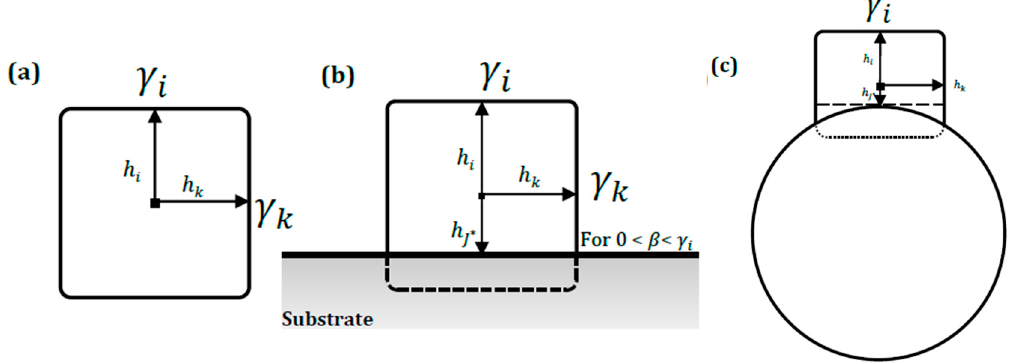
Figure 10. Idealized 2D representation of equilibrium shape of a single cubic copper nanostructure: ( a ) as free crystal according to the Gibbs–Wulff theory; ( b ) on a planar substrate as proposed in the Gibbs–Wulff–Kaischew shape theory; ( c ) on a curved fiber surface.